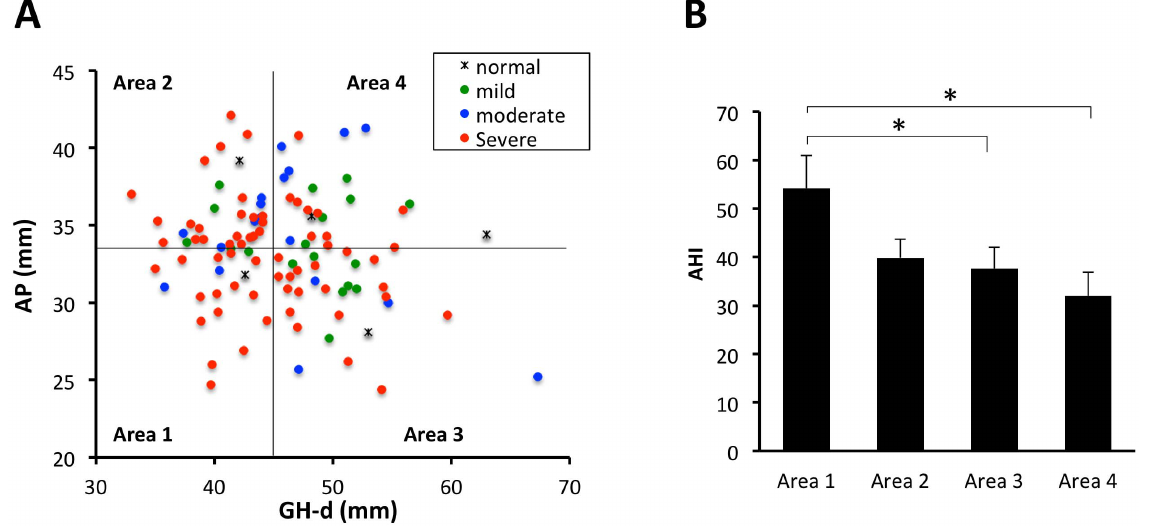
Figure 4. Comparison of four groups of patients with sleep apnea divided by mean length of GH-d and AP. A . Plot of all subjects (n=101) by GH-d and AP. All plots were divided into four areas according to the mean values of GH-d and AP. The mean value of GH-d was 45.4 6 5.9 mm, and AP was 33.4 6 3.8 mm. A rea 1 , GH-d , 45.4 and AP , 33.4; area 2 , GH-d , 45.4 and AP $ 33.4; area 3 , GH-d $ 45.4 and AP , 33.4; area 4 , GH-d $ 45.4 and AP $ 33.4. B . The mean AHI from four areas were compared. The mean AHI of area 1 was 54.2 6 26.2, which was significantly higher than area 3 (37.6 6 23.3) or area 4 (31.9 6 24.9). (t-test, p=0.04 and 0.01, respectively). doi:10.1371/journal.pone.0081590.g004 PLOS ONE |